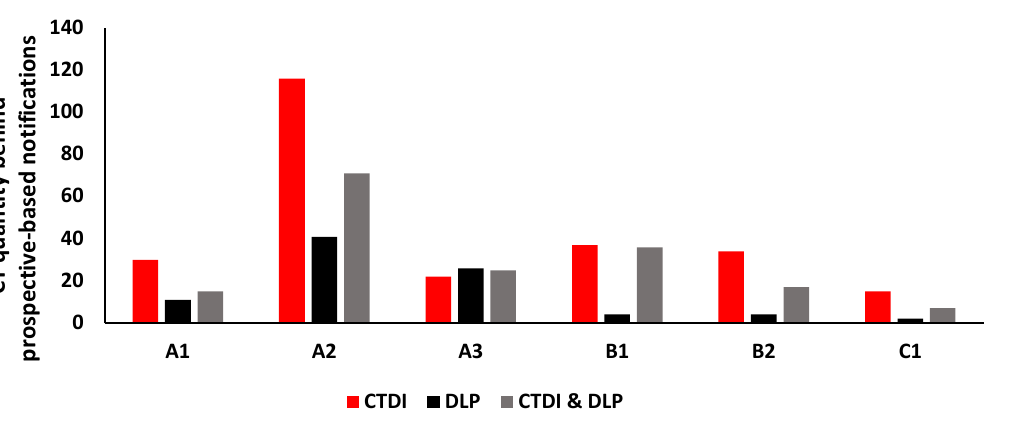
Figure 4. Demonstrates the CT dose quantities associated with notification counts using the pro- spective tool (CT system console) across the 6 CT scanners during the 6-month period.